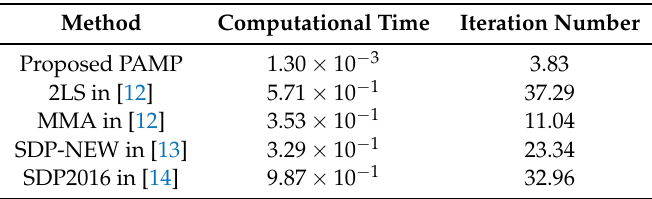
Table 2. Average computational time (in seconds) and average iteration number for the near-field case in scenario 1.